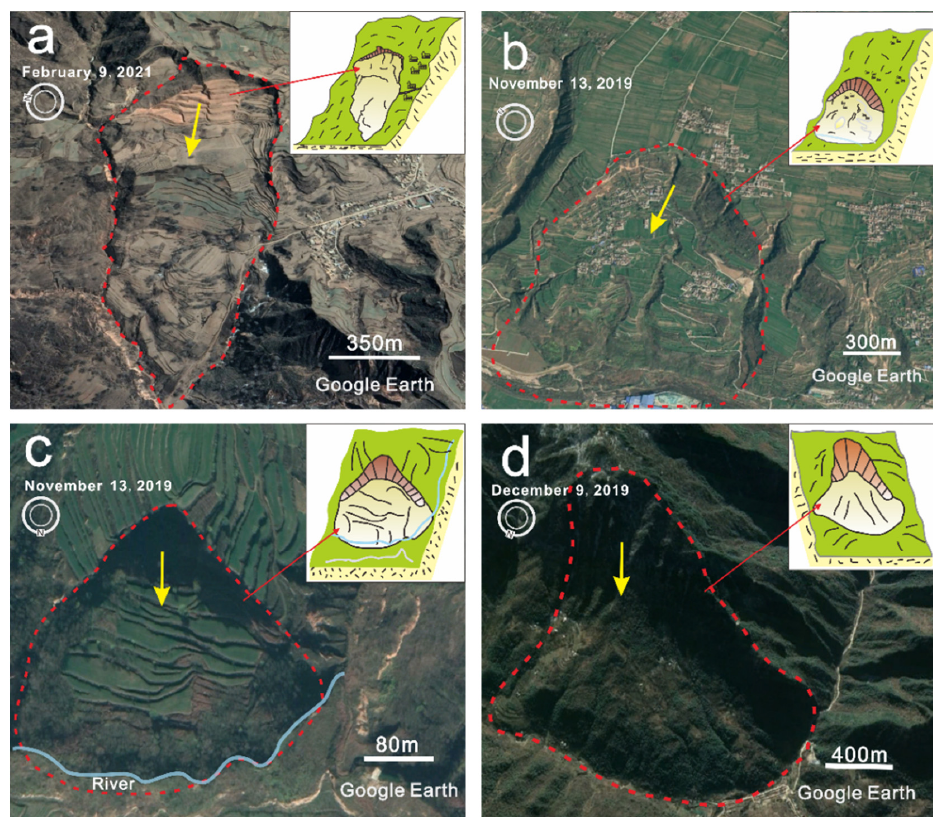
Figure 4. Interpretation of landslides at four sites of the study area. The red box represents the interpreted landslide boundary and yellow arrow represents the sliding direction. Image source: Google Earth. The illustration in the upper right corner of the remote sensing image shows cartoon diagram of the landslide. Site: ( a ) (35°03 ′ 01 ″ N, 106°56 ′ 14 ″ E), ( b ) (34°28 ′ 30 ″ N, 107°7 ′ 13 ″ E), ( c ) (34°30 ′ 29 ″ N, 107°8 ′ 15 ″ E), ( d ) (33°52 ′ 25 ″ N, 106°40 ′ 50 ″ E).